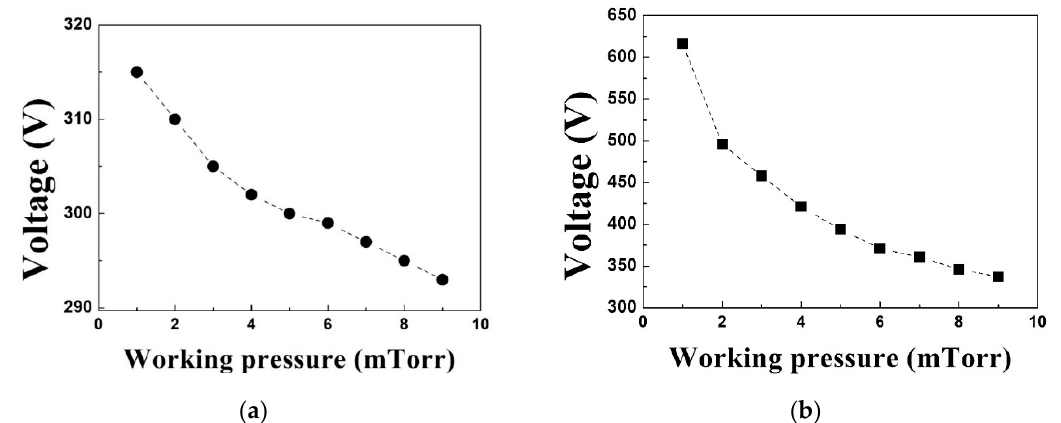
Figure 6. Discharge voltage with respect to working pressure for ( a ) open-type FTS (OFTS) and ( b ) closed-type FTS (CFTS).